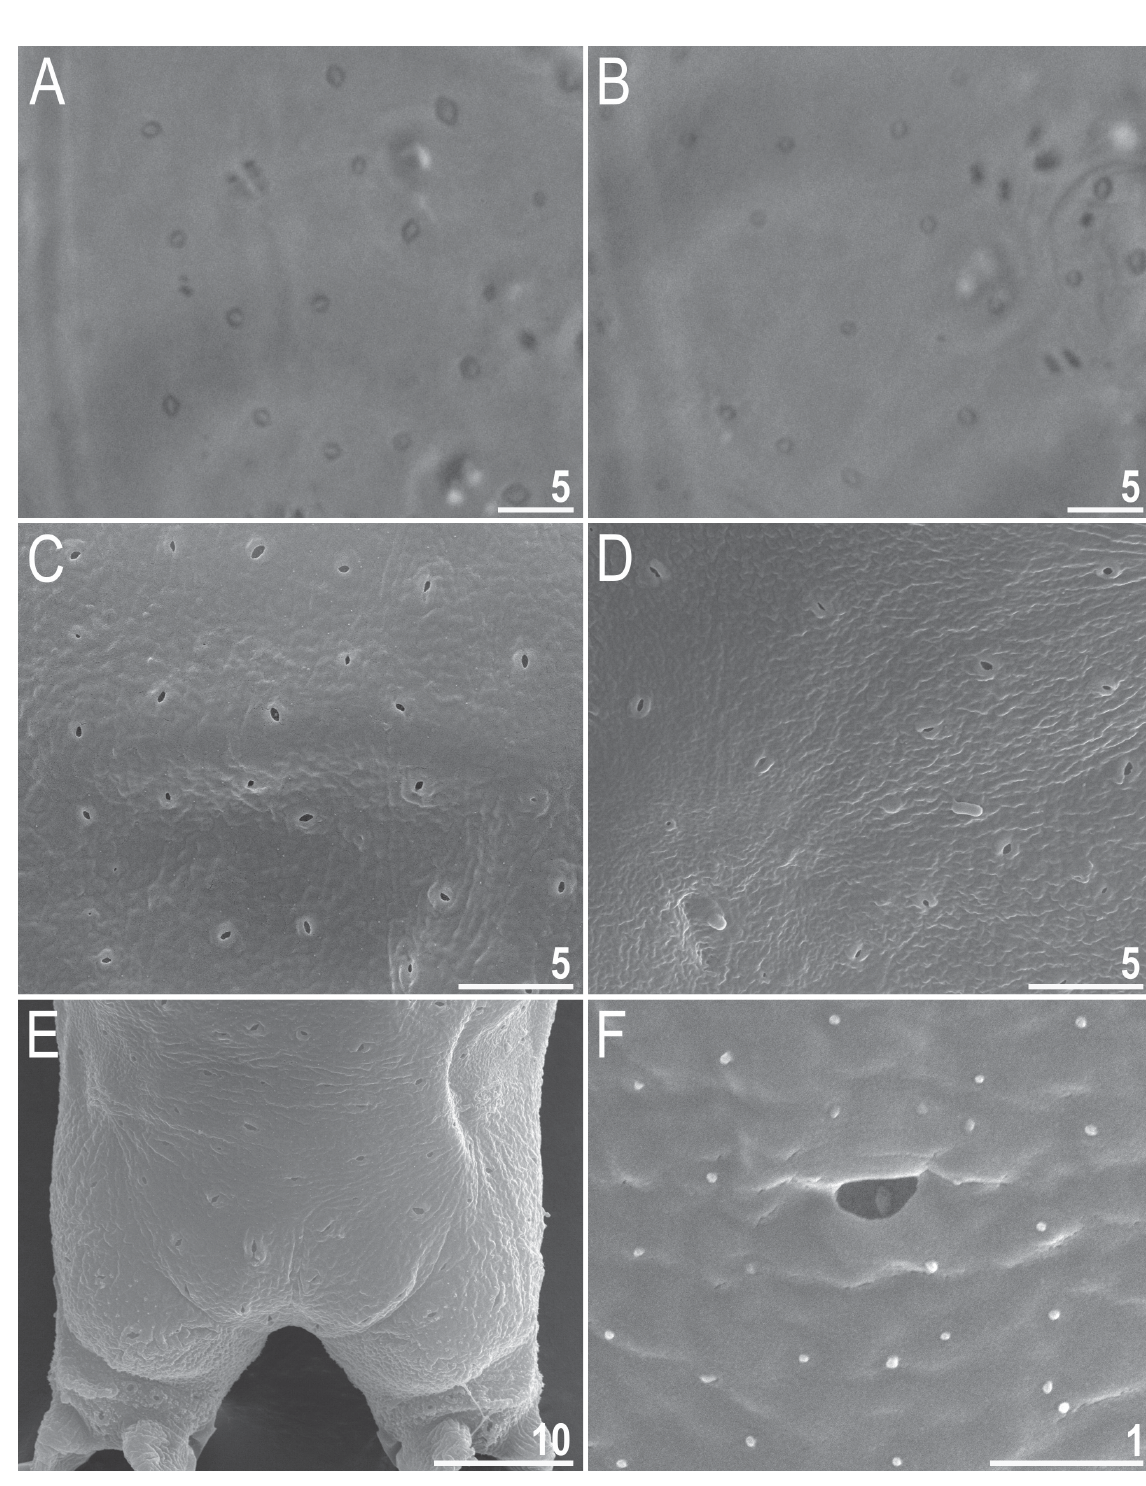
Fig. 2. Macrobiotus canaricus sp. nov., paratypes, body cuticle. A–B . Pores on the dorsal and ventral cuticle, respectively (PCM). C–D . Pores on the dorsal and ventral cuticle, respectively (SEM). E . Pores and fine granulation on the dorso-posterior cuticle (SEM). F . Close-up of a pore and granulation on the dorso-posterior cuticle (SEM). Scale bars in